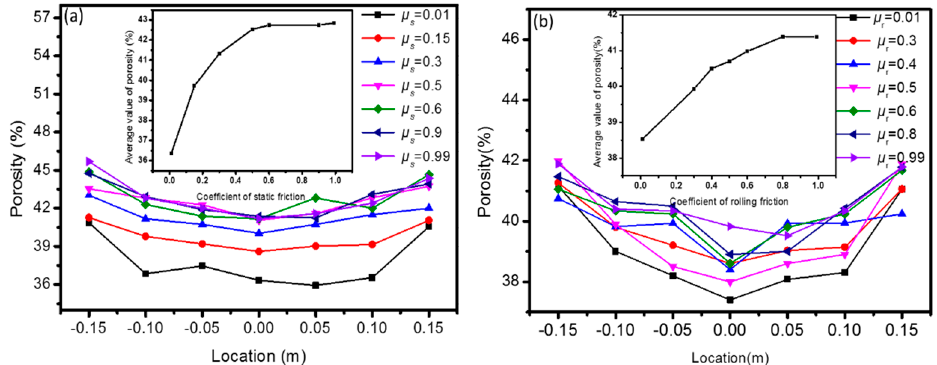
Figure 11. BPD of the pellet pile and the inserted graph is the average porosity (the average value of seven points on a curve) with different ( a ) static and ( b ) rolling friction coefficients.